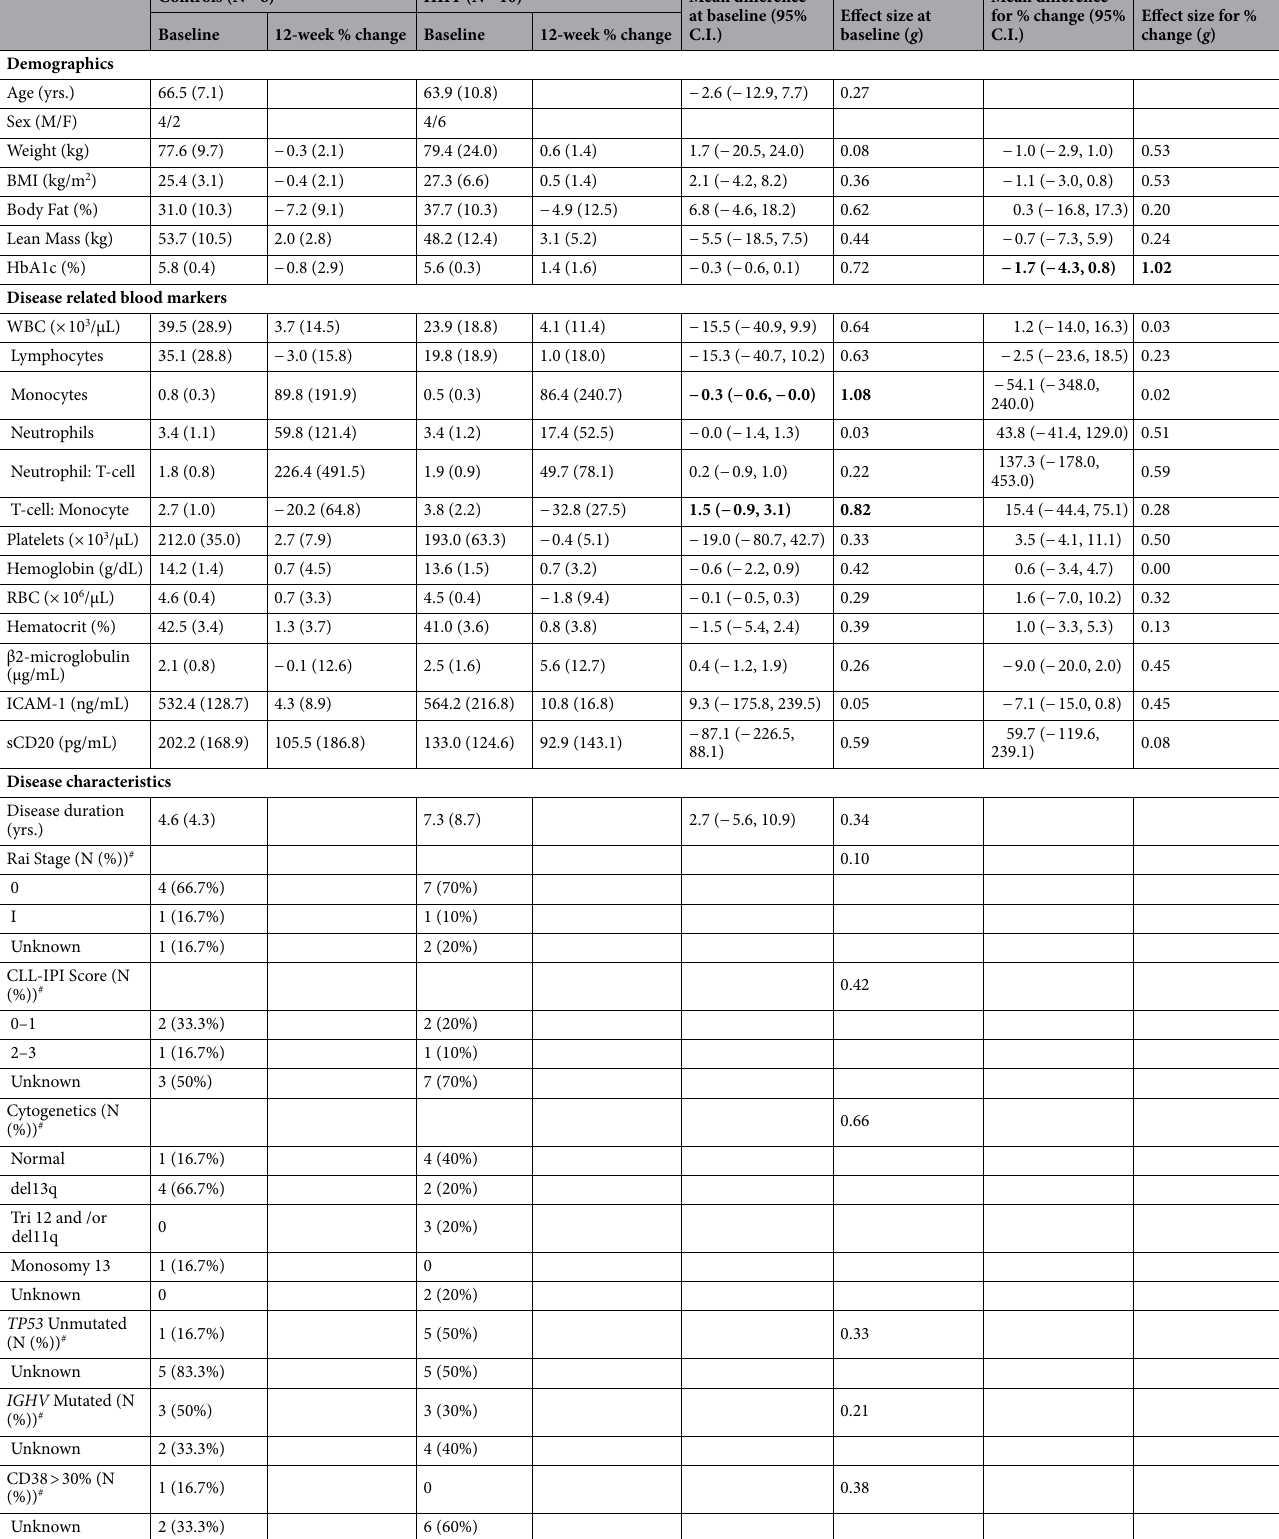
Table 2. Baseline and percentage changes upon study completion for demographics and clinical characteristics of participants completing the intervention. HbA1c (hemoglobin A1c); RBC (red blood